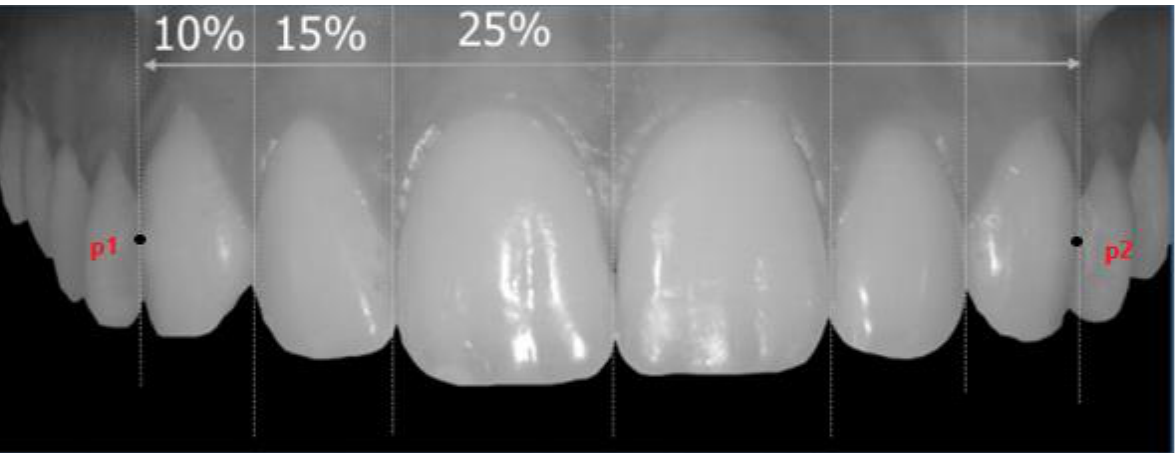
Figure 3. Representative image of GM theory. The distance between points p1 and p2 represents the inter-canine distance.